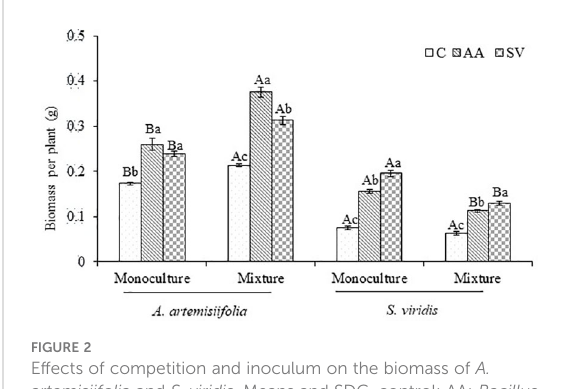
FIGURE 2 Effects of competition and inoculum on the biomass of A. artemisiifolia and S. viridis . Means and SDC, control; AA: Bacillus from the rhizosphere soil of A. artemisiifolia in the monoculture; SV: Bacillus from the rhizosphere soil of S. viridis in the monoculture. Different uppercase letters indicate signi fi cant differences between mixture treatments and monoculture treatments receiving the same microbial inoculations at P < 0.05. Different lowercase letters indicate signi fi cant differences among inoculation of different Bacillus at P <0.05. Error bars represent ±SD of mean ( n =10).